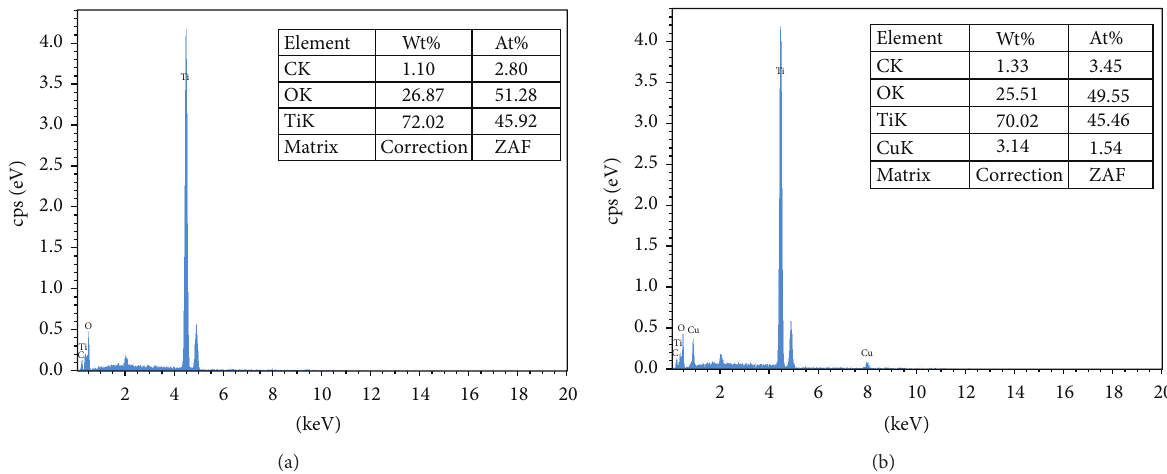
Figure 6: EDX spectra of (a) TiO 2 and (b) Cu 2 N 3 -TiO 2 . The insets in (a) and (b) show the element analysis of composites.